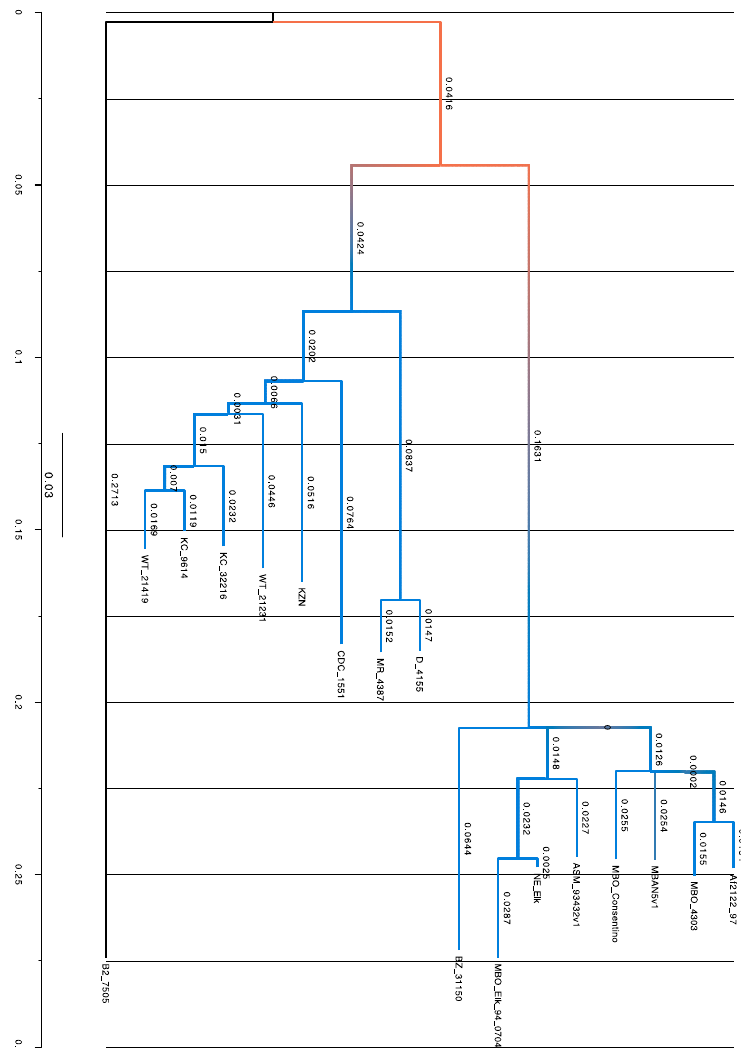
Figure 2. Molecular phylogenetic analysis of Mycobacterium tuberculosis complex organisms by the maximum likelihood method. Evolutionary history was inferred by using the maximum likelihood method based on the Hasegawa–Kishino–Yano model (94). The tree with the highest log likelihood (-49,783.9307) is shown. The percentage of trees in which the associated taxa clustered together is shown next to the branches. Initial tree(s) for the heuristic search were obtained automatically by applying Neighbor-Join and Bio neighbor joining algorithms to a matrix of pairwise distances estimated using the maximum composite likelihood (MCL) approach, and then selecting the topology with the superior log likelihood value. The tree is drawn to scale, with branch lengths measured in the number of substitutions per site. The analysis involved 17 nucleotide sequences. Codon positions included were first + second + third + noncoding. All positions containing gaps and missing data were eliminated. There was a total of 7248 positions in the final dataset.